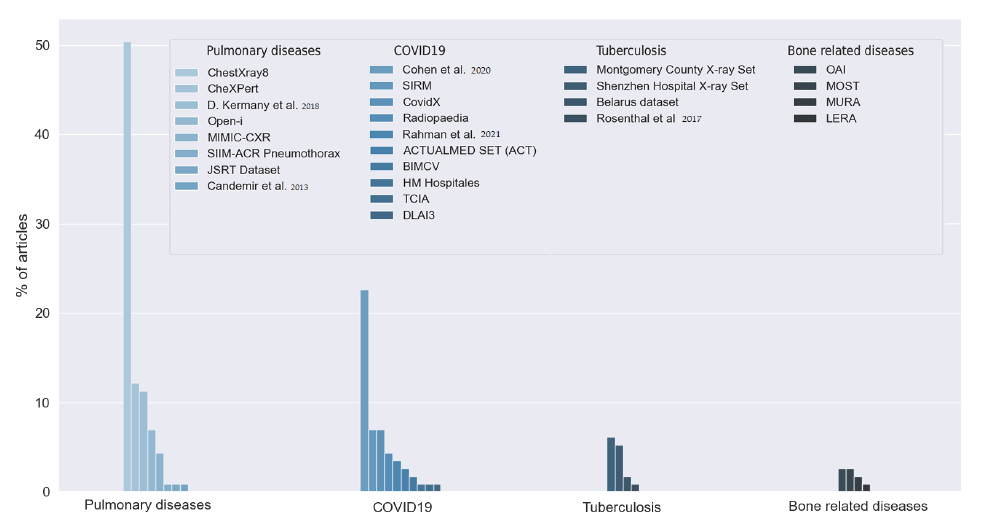
Figure 9. Datasets used by the reviewed articles. Answers to RQ3. Vertical axis indicates the percentage of articles for each category. D. Kermany et al. [28], Candemir et al. [29], Cohen et al. [30], Rahman et al. [31] and Rosenthal et al.